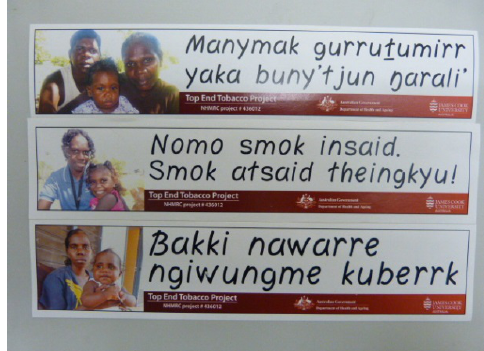
Figure 3. Local language stickers encouraging—smoke-free